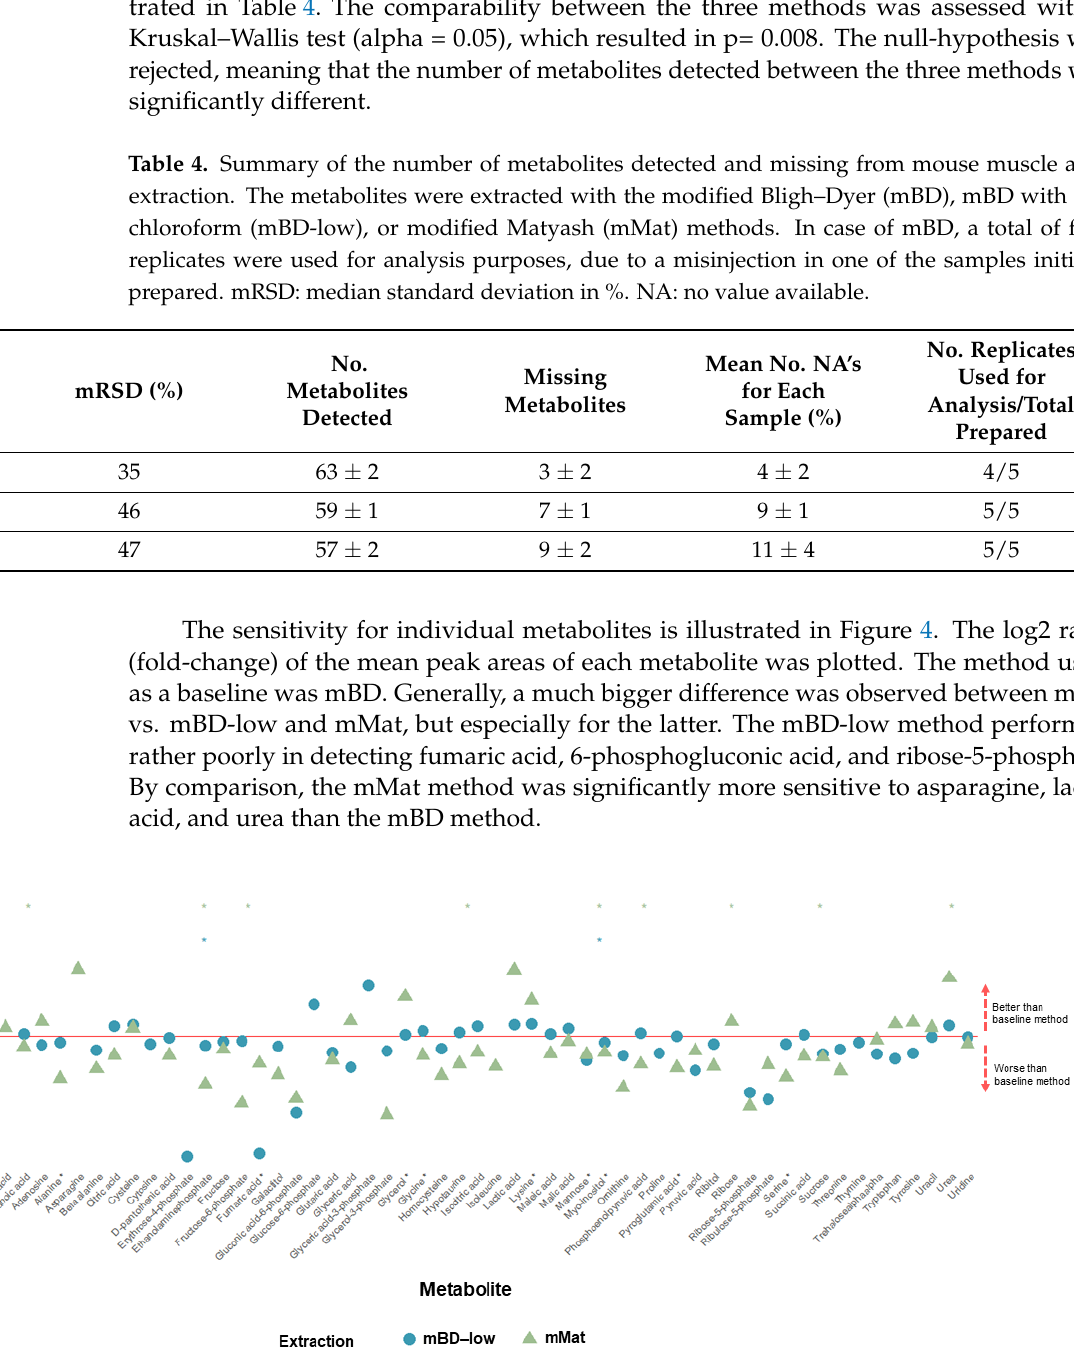
Figure 4. Muscle tissue: Relative quantification represented as fold change of single metabolite peak areas using cinnamic acid normalization. Modified Bligh–Dyer (mBD) used as baseline and represented by the red line. Extraction sensitivity with significant variation represented in the upper panel. *: p –value < 0.05.